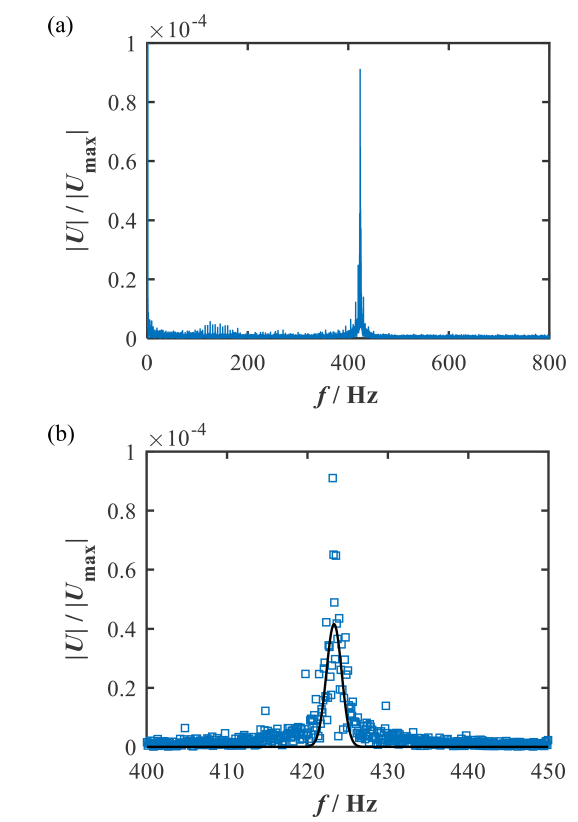
Figure 14. Results of the piezoresistive measurement. Frequency spectrum after fast Fourier transform at a mass loading of 1mg (a) and a section of the frequency spectrum with the fit of a Gaussian function (b) .